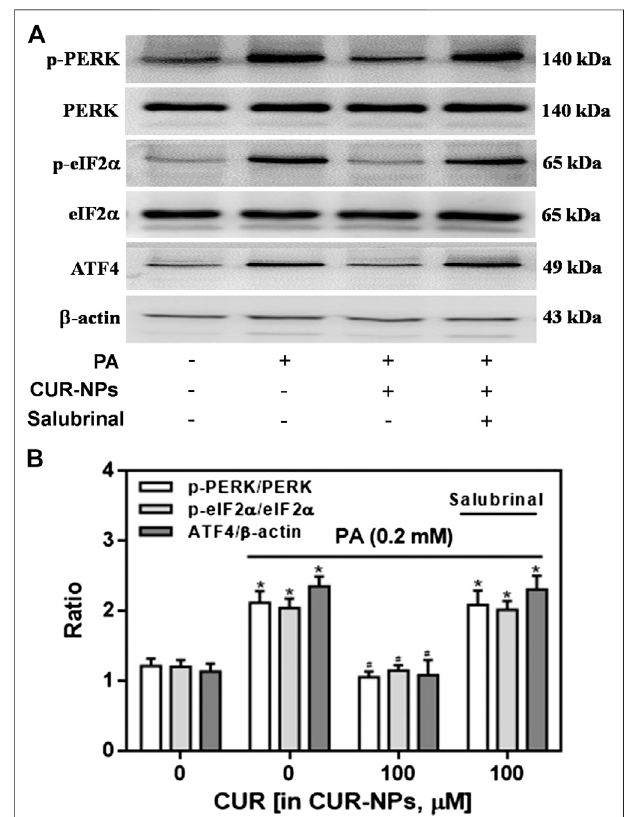
FIGURE 7 | Effects of CUR-NPs on the expression of PERK/eIF2 α / ATF4 pathway-related proteins in cardiomyocytes exposed to PA (A) Representative images of p-PERK, PERK, p -eIF2 α , eIF2 α , ATF4 and β -actin expression by western blot (B) Quantitative analysis of the p-PERK/ PERK, p -eIF2 α /eIF2 α andATF4/ β -actin.Salubrinal:30 μ M* p < 0.0 5vs control group; # p < 0.05 vs PA group; $ p < 0.05 vs PA + CUR